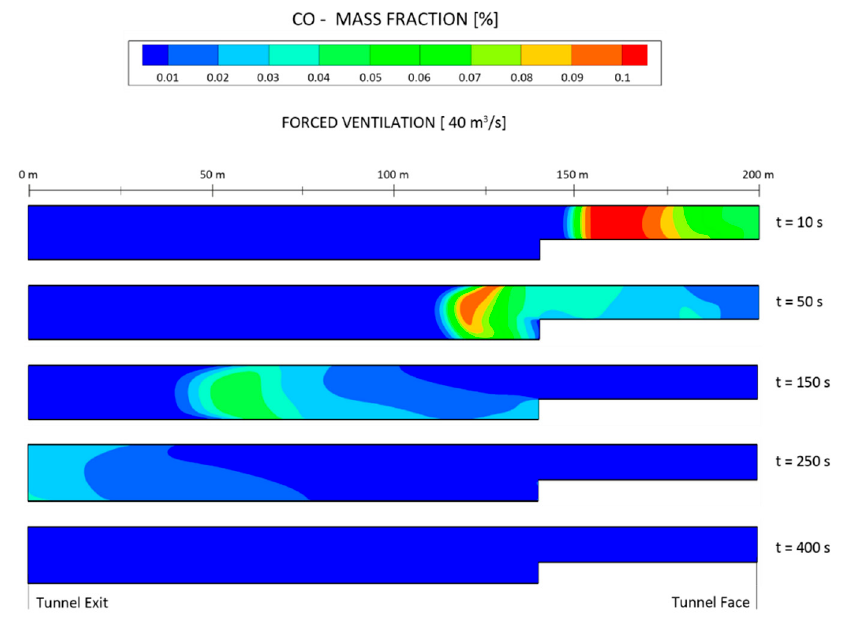
Figure 15. Distribution of the CO mass fraction at the longitudinal central section of X = 0 m at different times, under forced ventilation and considering an airflow of 40 m 3 s − 1 .